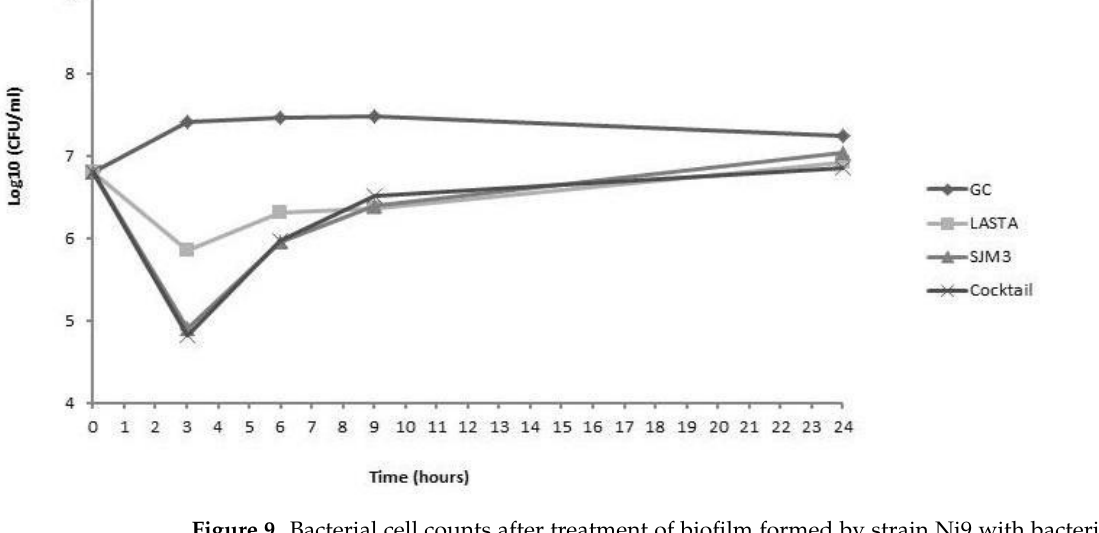
Figure 9. Bacterial cell counts after treatment of biofilm formed by strain Ni9 with bacteriophage LASTA, SJM3 and a cocktail of both. A similar reduction of viable cell count of 2.51 and 2.59 log units was observed 3 h after treatment of biofilm with phage SJM3 and cocktail of the two phages. Phage LASTA produced 1.56 log reduction in the same time, whereas after 24 h, no difference in CFU numbers was observed between treated samples and untreated control. GC, growth control without phages.